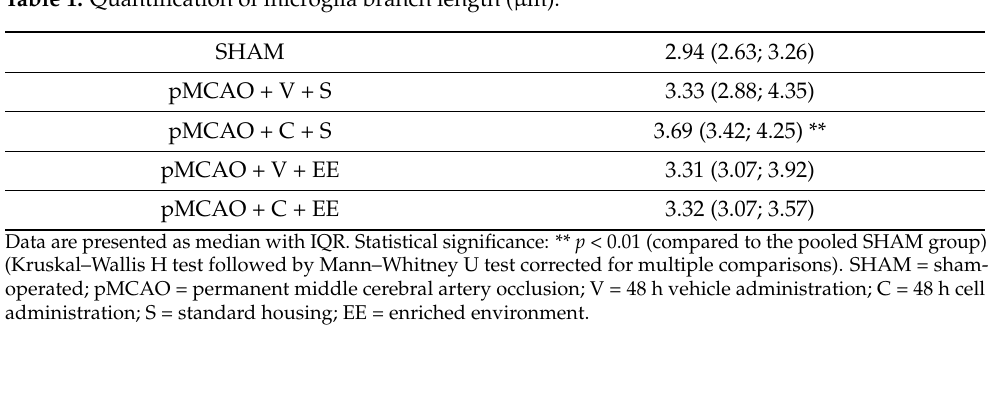
Figure 4. Skeletonization of perilesional Iba1+ cells. Original photomicrographs and their corresponding binary masks and skeletons showing the ramifications of the highlighted Iba1+ cells of representative SHAM ( A – C ) and pMCAO ( D – F ) animals. Scale bar 100 µm ( A , D ). Table 1. Quantification of microglia branch length (µm).